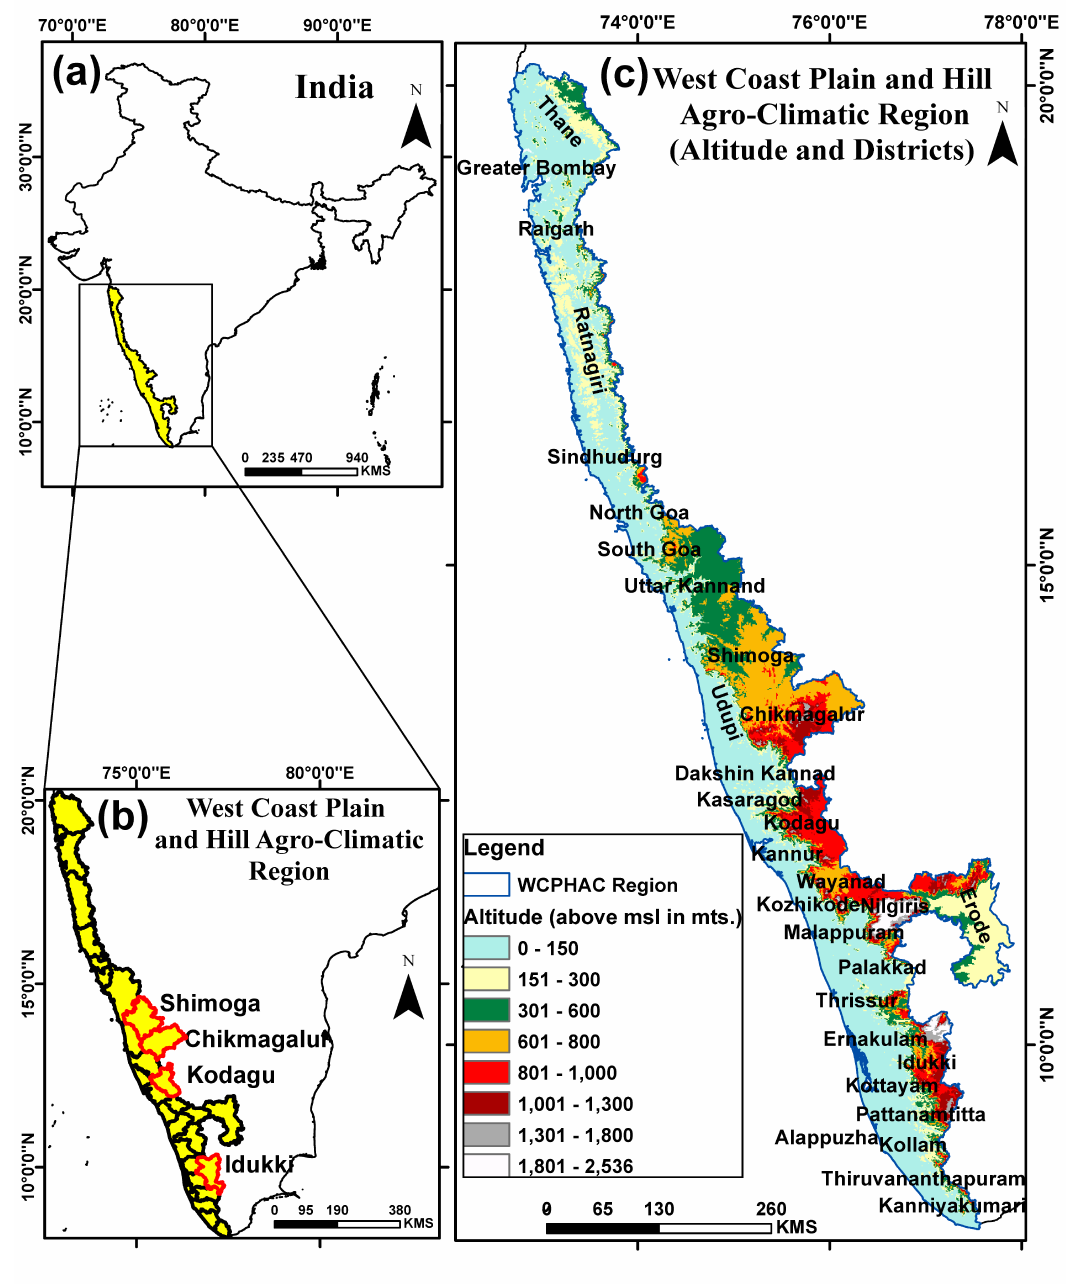
Figure 1. ( a , b ) Location map of the WCPHAC region in India and peninsular India respectively. Districts used for validating the rainfall in the WCPHAC region are highlighted with red color administrative boundary in ( b ). ( c ) The altitude of the region. The name of each district in the WCPHAC region is inside the administrative boundary of each